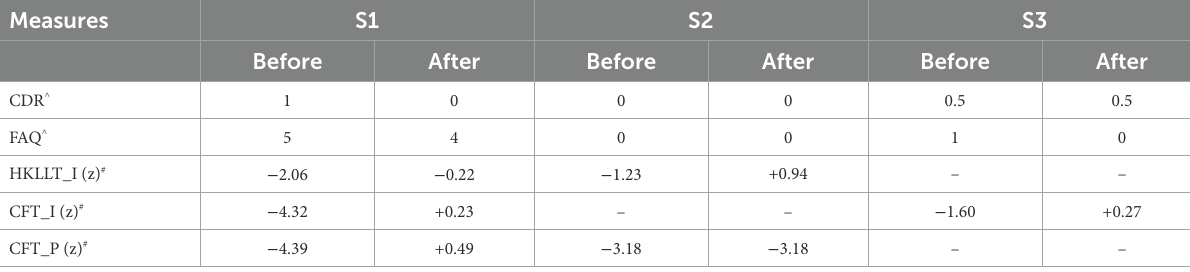
TABLE 2 Scores obtained in cognitive and functional abilities tests before and after